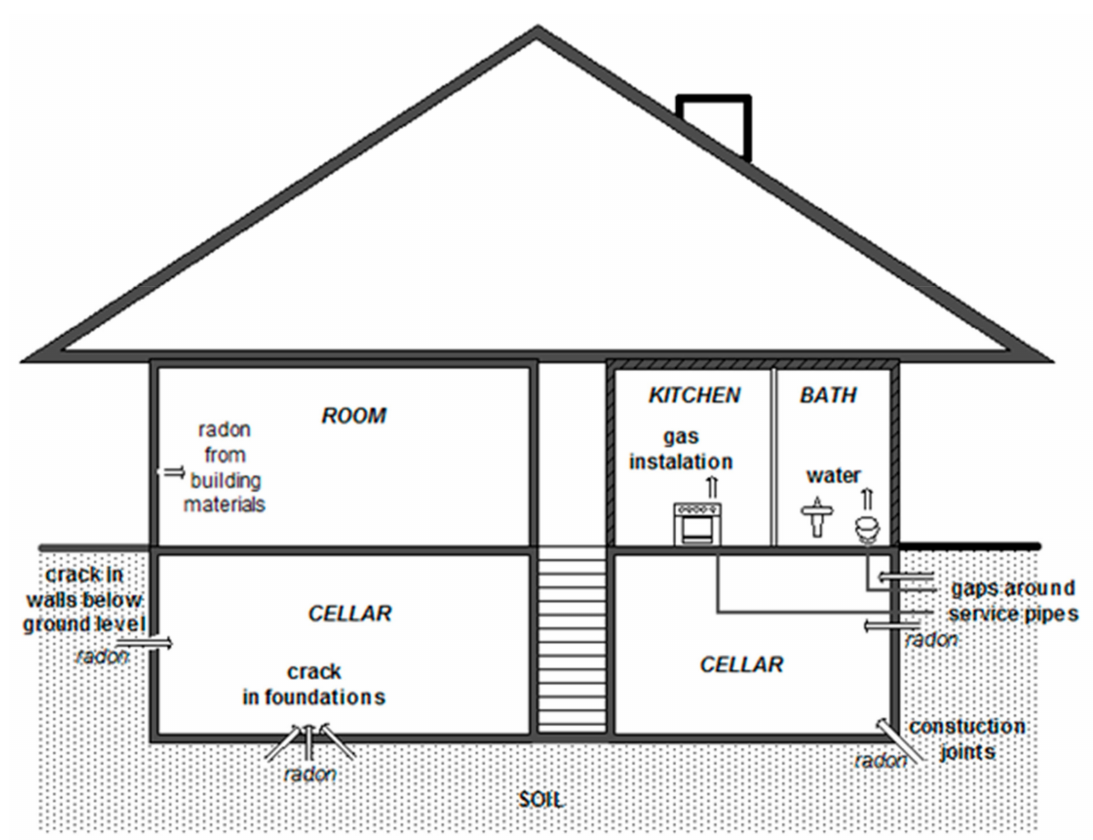
Figure 1. Radon pathways into